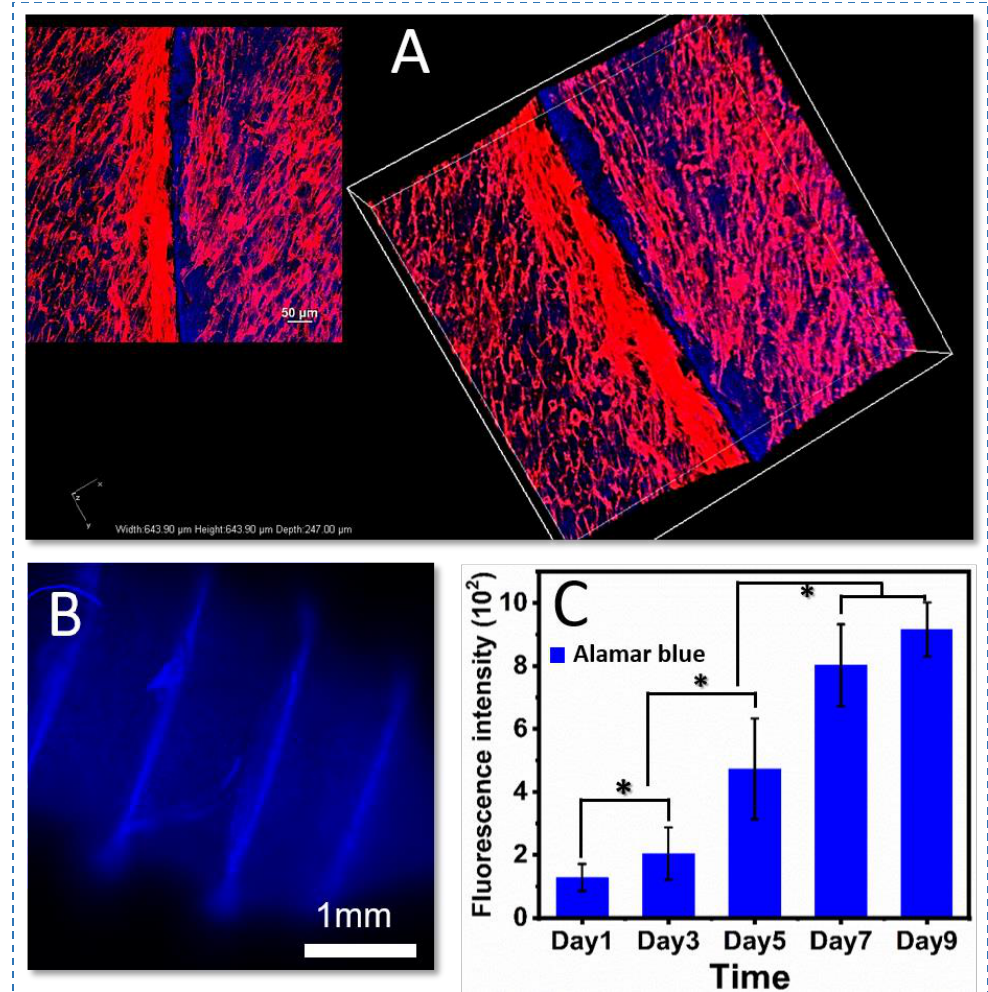
Figure 8. Fluorescence staining of actin (red) and nuclei (blue) of hBMSCs on the silk screws composites in growth medium at day 7 ( A ). ( B ) represents silk screws unloaded hBMSCs. The cells spread out actin filaments, evenly distributed on the screws after 7-day culture. Alamar blue assay ( C ) showed the metabolic activity and proliferation of hBMSCs on the screws (n > 3) over a 9-day culture period. Silk screw unloaded cells served as a control (* p < 0.01).